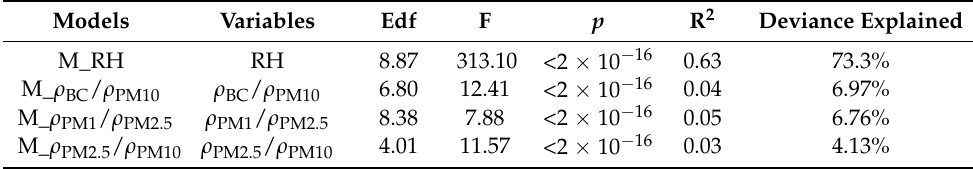
Table 3. Simulation results by the GAMs with single influencing